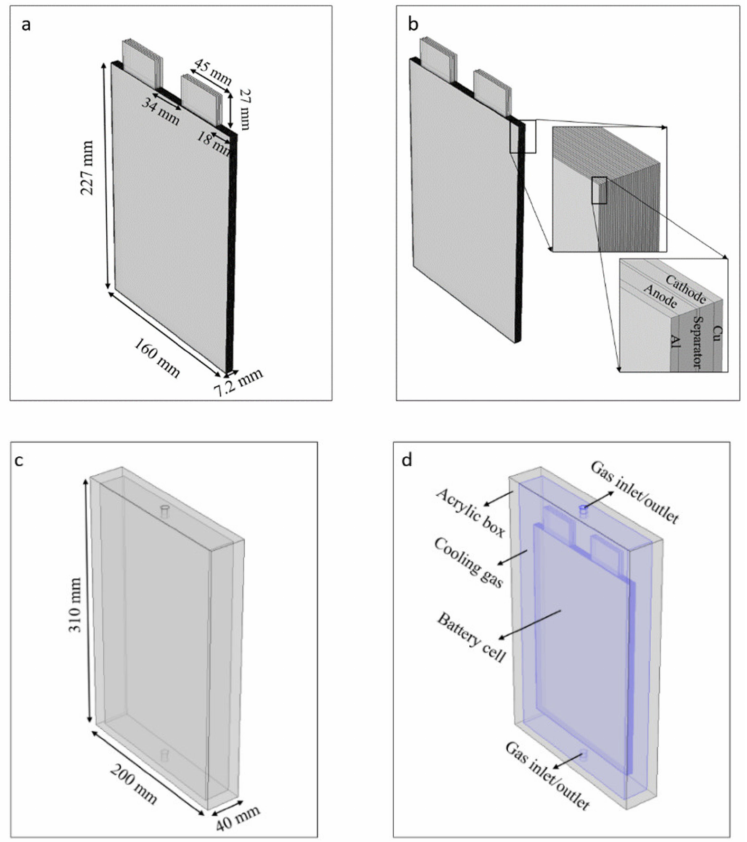
Figure 3. ( a ) dimensions of a single cell; ( b ) schematic of a multilayer cell; ( c ) dimensions of a cooling box; and ( d ) a battery cell cooling